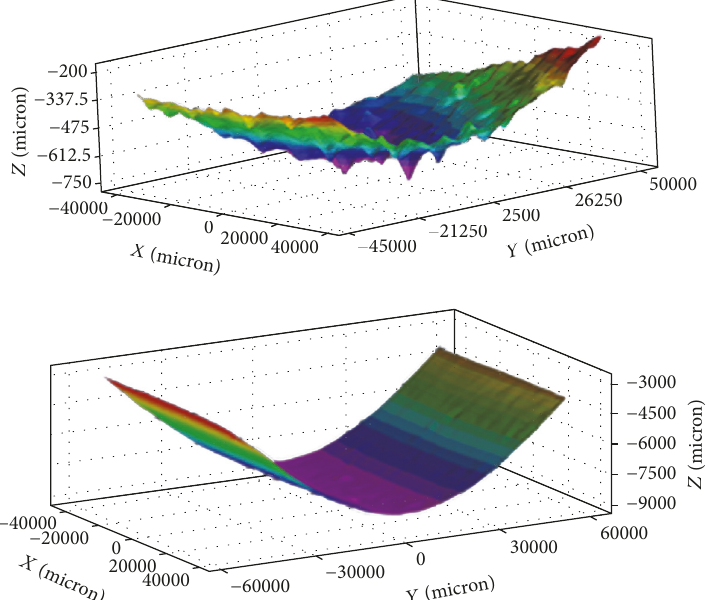
Figure 20: DIC: First and last step-3D plot-central delamination